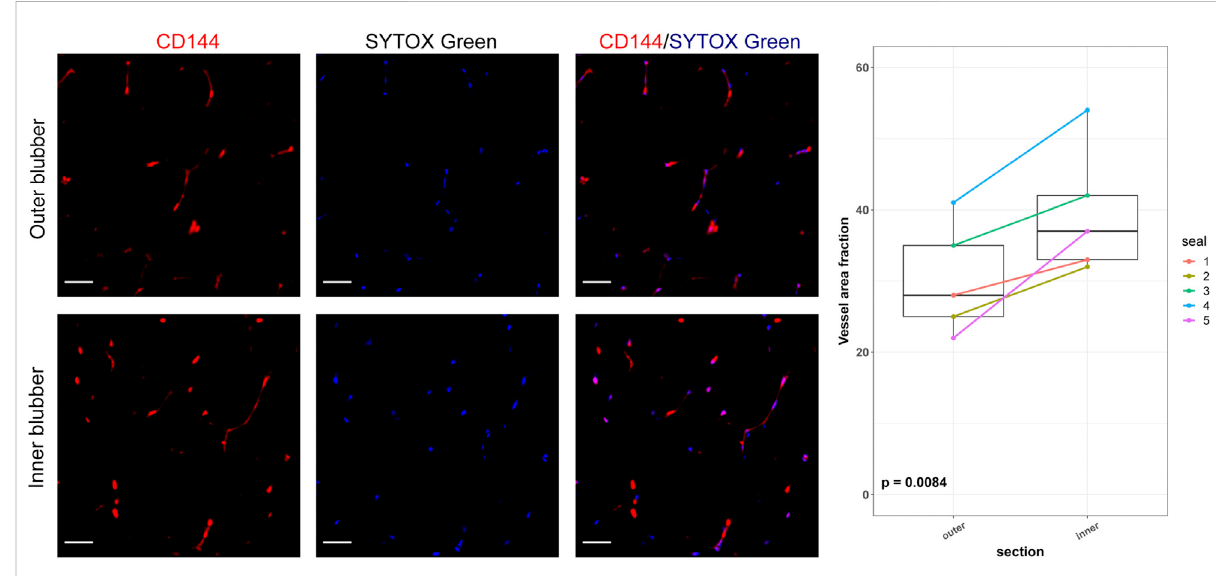
FIGURE 3 Vascular area fractions in inner and outer blubber tissue layers. Sections of inner and outer blubber of juvenile northern elephant seals ( n = 5) were stained with CD144 (vascular endothelial cadherin) antibody. Nuclei were counterstained with SYTOX Green. Vascular area fractions were compared between blubber layers using paired t-test. Scale bar is 50 μ